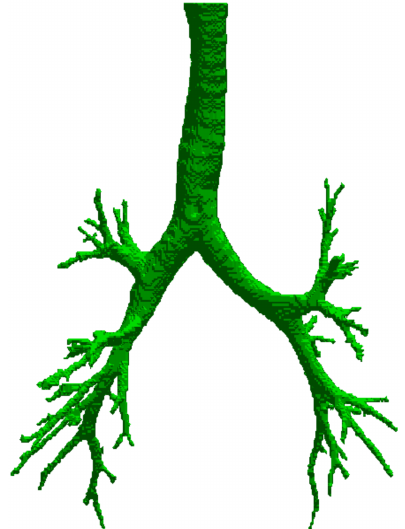
Figure 16. Corrected pulmonary airways.